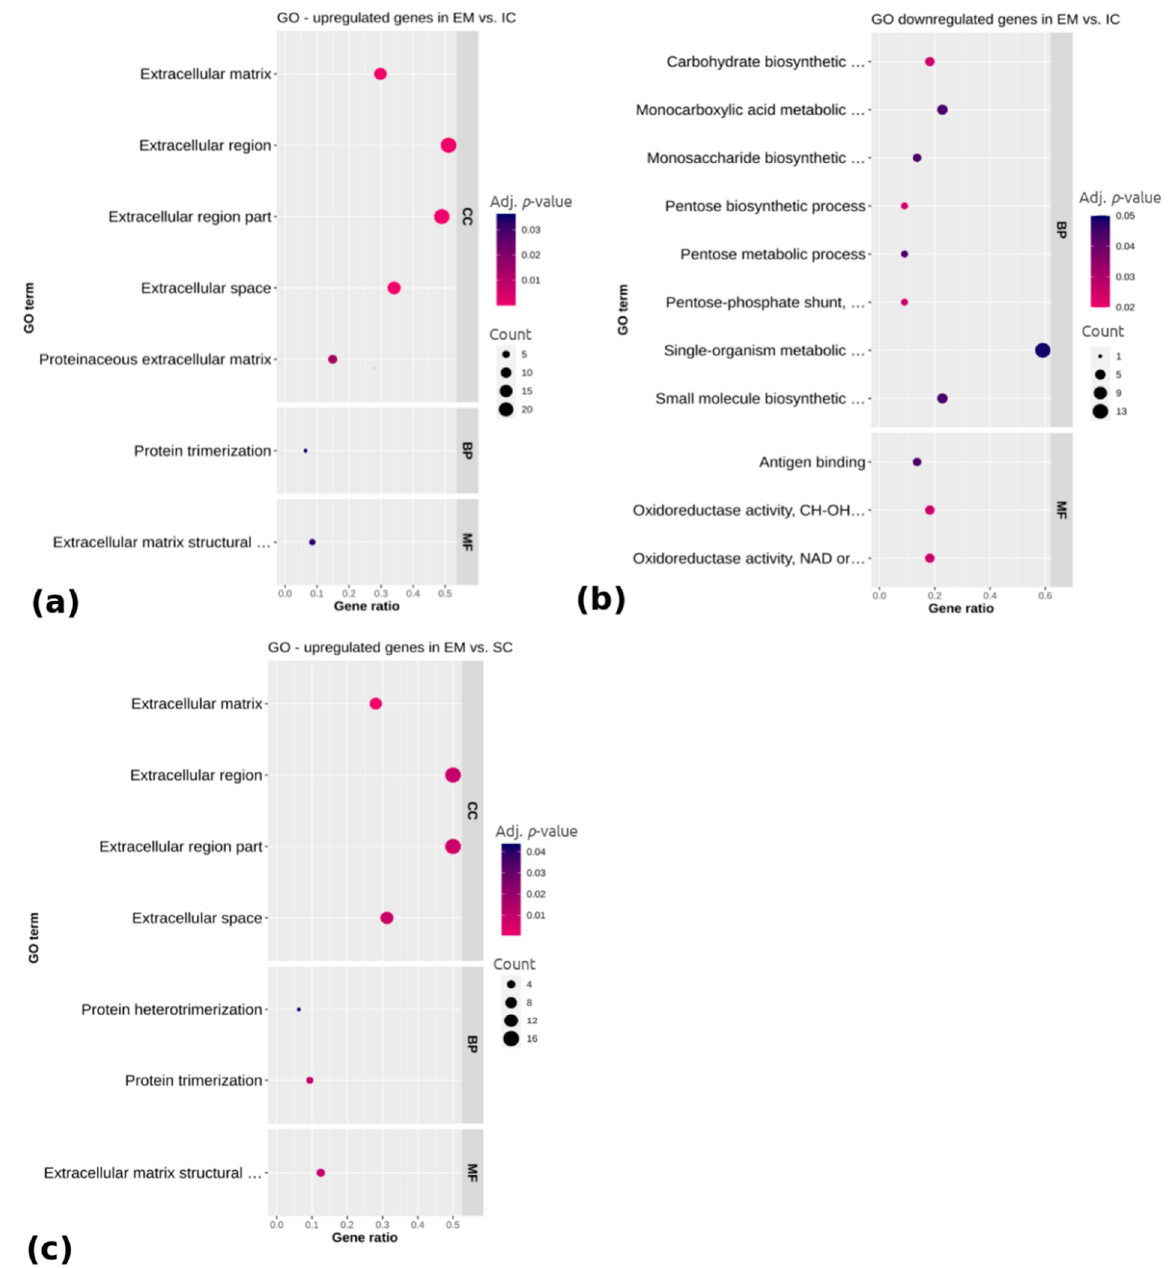
Figure 3. Functional categorization of differentially ( a ) upregulated and ( b ) downregulated genes between EM and IC and ( c ) upregulated genes between EM and SC. Gene ontology (GO) enrichment analysis is representing cellular component category (CC), biological process category (BP) and molecular function category (MF). Gene ratio is the ratio between differentially expressed genes and total differentially expressed genes in the given GO term. EM = entire males; IC = immunocastrated pigs; SC = surgically castrated pigs.